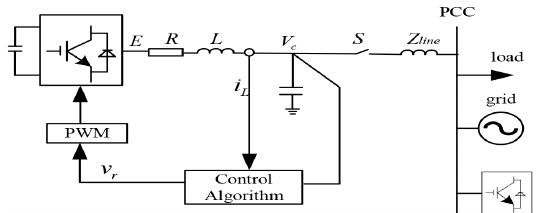
Figure 1. Inverter structure of microgrids.